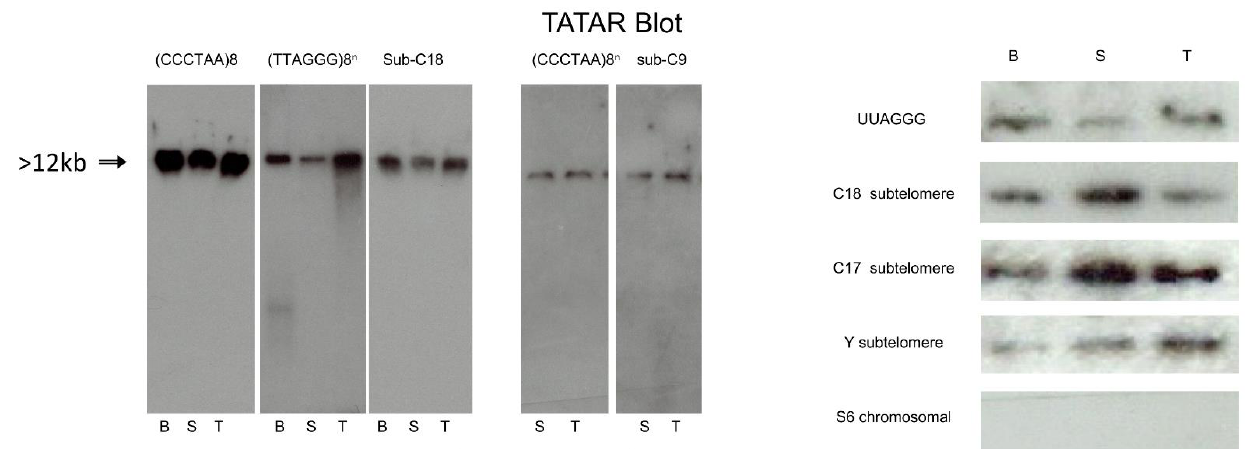
Figure 3. TERRA transcripts originate from subtelomeric promoters. Tatar blot (telomere-associated TERRA RNA) was performed with brain, sperm, and testis extracted DNA/RNA complexes, purified and digestion with MsP1, electrophoresis, transfer of complexes, and hybridization with different probes. From left to right: In parallel membranes are hybridized with P 32 Probe (CCCTAA) 8n to reveal Leading DNA strand (telomeres) and RNAs (TERRA), Probe (TTAGGG) 8n to reveal Lagging DNA strand (complementary strand telomeres), Sub-C18 (subtelomeric chromosome 18), and sub-C9 (subtelomeric chromosome 9). Right: different probes (top to bottom) for TTAGGG repeat (eight-fold), subtelomeric sequences of chromosomes 18, 17, and Y (schematized as xxx in Figure 2a), and S6 ribosomal RNA as a negative control (see Supplementary Table S2 for corresponding oligos nucleotides sequences). The chromosomal sequences were randomly taken from the mm10 mouse genome assembly and checked in each case to be unique in the whole genome.